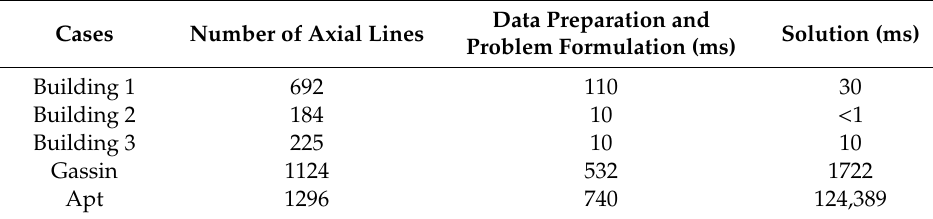
Table 1. Computation time of the sample